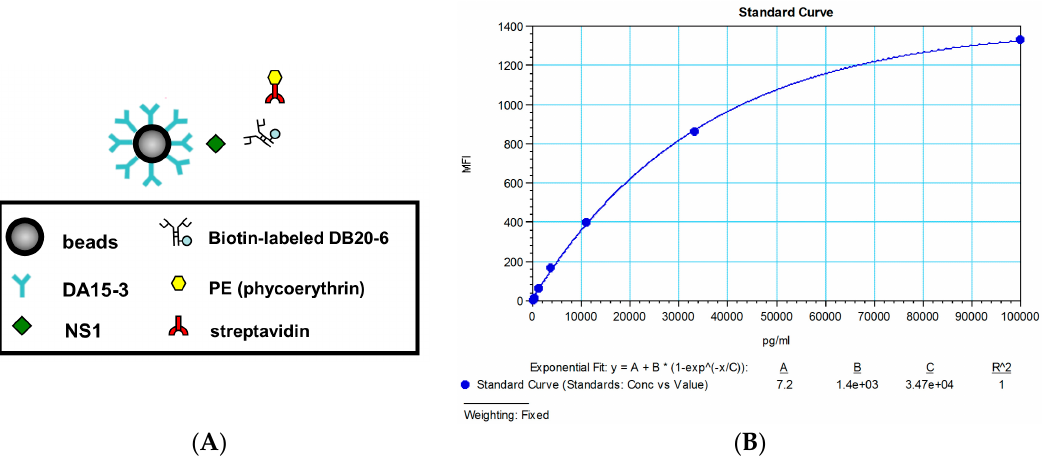
Figure 3. Development of a flow cytometry-based diagnostic platform for DENV1. ( A ) Schematic describing the diagnostic platform; ( B ) Standard curve of DENV1 NS1 for the flow cytometry-based diagnostic platform. MFI means the mean fluorescence intensity.